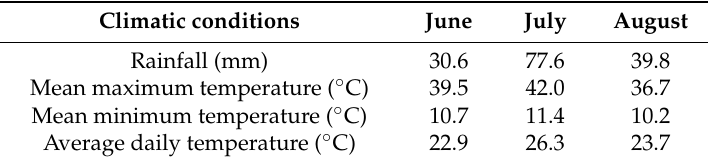
Table 1. Rainfall and temperature in the three months during in the grapevines were monitored (June, July and August 2015).